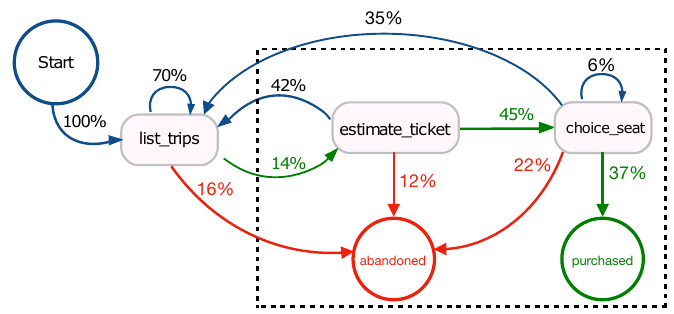
Figure 5. Process mining algorithms applied to user event